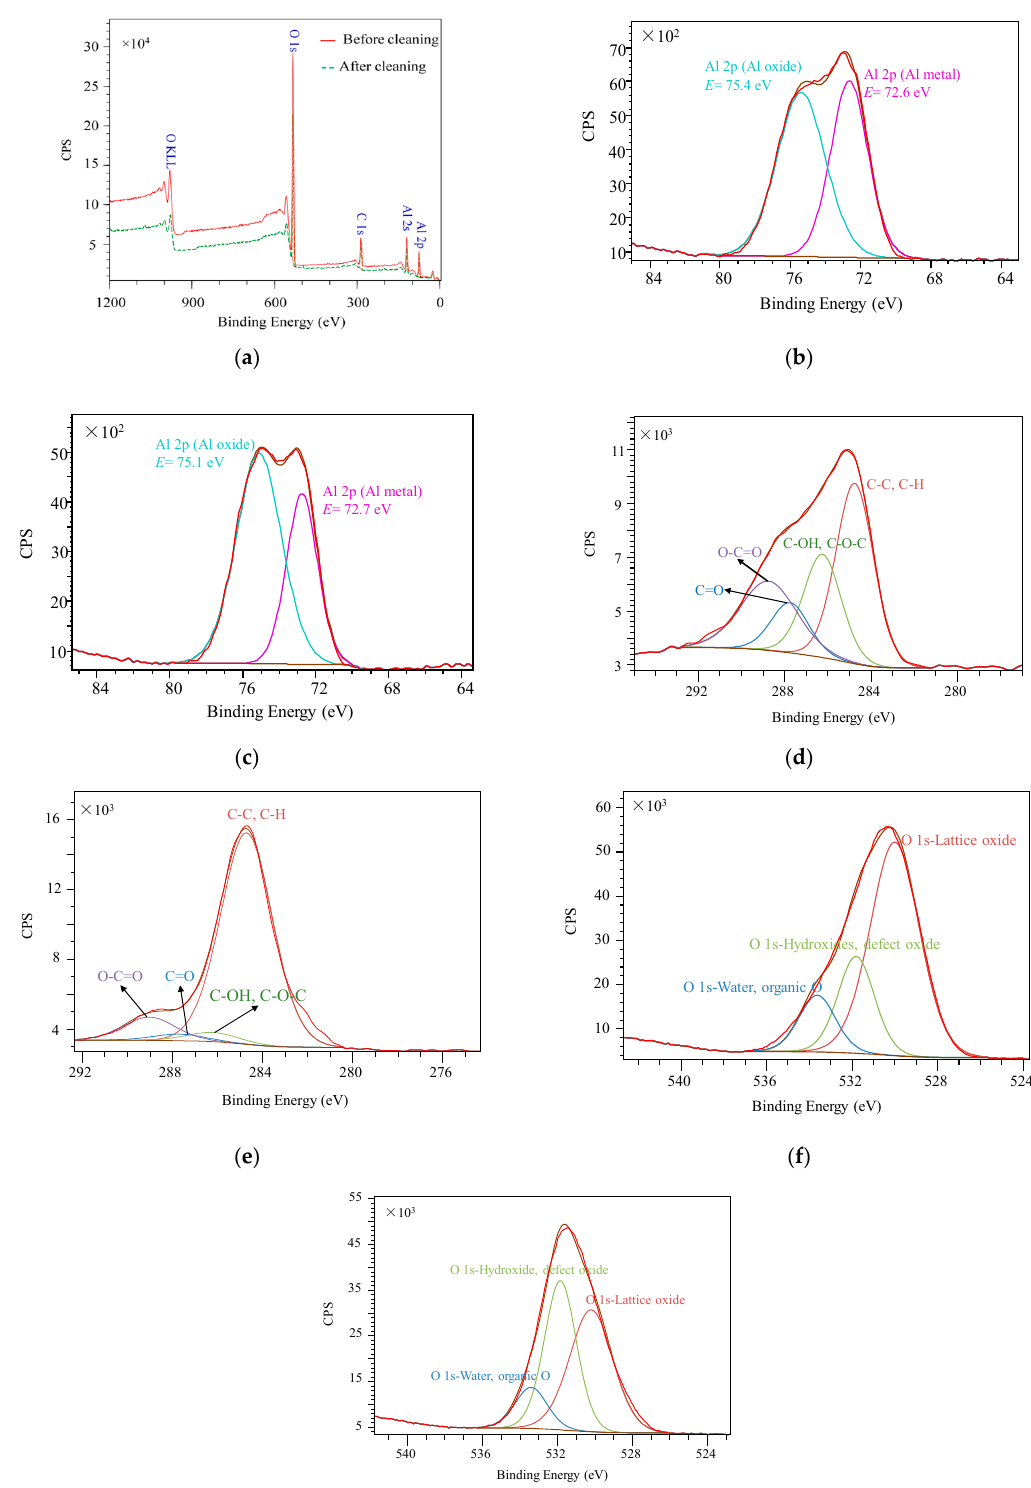
Figure 5. XPS spectra and curve fitting of laser treated sample #1. ( a ) The wide scan; ( b ) Al 2p peak of the uncleaned one; ( c ) Al 2p peak of the cleaned one; ( d) C 1s peak of the uncleaned one; ( e ) C 1s peak of the cleaned one; ( f) O 1s peak of the uncleaned one; ( g ) O 1s peak of the cleaned one. Peak fitting was adopted using CasaXPS Version 2.3. The charging was found during the XPS analysis, which was compensated by shifting the adventitious carbon peak to 284.8 eV. Gaussian (30%)–Lorentzian (70%) peak shape was employed for the curve fitting of the Al 2p, C 1s, and O 1s peaks for uncleaned and cleaned laser processed aluminum alloy sample #1. The XPS wide scan of sample #1 identified the major constituents of aluminum, carbon, and oxygen elements. As shown in Table 2, compared to the aluminum and oxygen element concentrations of uncleaned sample #1, the concentrations of the cleaned ones decreased about 1.9% and 5.2%, respectively, while the concentration of the carbon element increased about 7.1%. Table 2. Quantification of the concentrations of the laser processed aluminum alloy sample #1 before and after ultrasonic cleaning by XPS analysis (at %). Conditions 45.4% In Figure 5a, the intensity drop in the XPS survey spectrum after cleaning may be related with the surface changes. As shown in Figure 5b,c, the concentrations of Al metal and Al oxide of sample #1 before and after ultrasonic cleaning were acquired by peak fittings. In Figure 5c, for cleaned laser treated sample #1, these two components, Al metal and Al oxide, were found at 72.7 eV and 75.1 eV, respectively, with the concentrations of 35.7% and 64.3%, respectively [31,32]. Before ultrasonic cleaning, the concentrations of Al metal and Al oxide were 45.2% and 54.8%, respectively. This result indicates that the concentration of Al metal decreased by 9.5% and the concentration of Al oxide increased after cleaning. An increase of the carbon content of about 7.1 at % after cleaning was observed, as indicated in Table 2. Quantification of the amounts of C–C/C–H (carbon), C–OH/C–O–C (alcohol etc.), C=O (ketones), and O–C=O (esters or acids) parts of uncleaned and cleaned sample #1 are shown in Figure 5d,e. These four fitting peaks of C–C/C–H, C–OH/C–O–C, C=O, and O–C=O were found at the binding energies of 284.8 (±0.1) eV [33], 286.3 (±0.1) eV [34], 287.8 (±0.1) eV [35], and 289.3 (±0.1) eV [36], respectively. In contrast to the C 1s spectrum of uncleaned sample #1, the concentration of the C–C/C–H part of the cleaned one increases about 43.2%, with a concentration decrease of C–OH/C– O–C, C–O, and O–C=O parts of nearly 9.9%, 8.8%, and 14.5% severally. It indicates that the carbon content increase after cleaning is mainly caused by the concentration increase of the C–C/C–H part. In other words, more adventitious carbon after ultrasonic cleaning contributes to the carbon content increase. This can be explained by the more sphere/spheroidicity-like grains formed during ultrasonic cleaning, which led to the increase of the surface areas. More adventitious carbons may be attached on the cleaned surface, finally contributing to the carbon content increase. Additionally, the distinct decrease of the O–C=O part after cleaning means that the esters or acids were partly removed during ultrasonic cleaning.